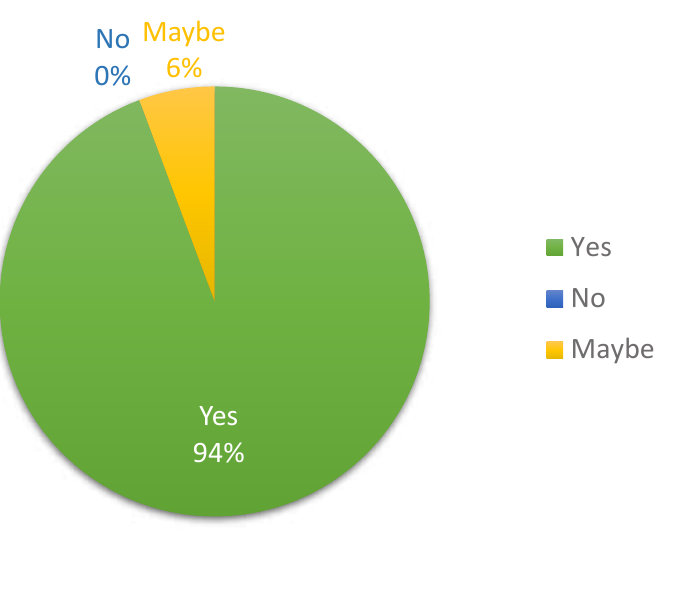
Figure 2. Percentage (%) of respondents on the possibility of the usage of e-banking as a marketing